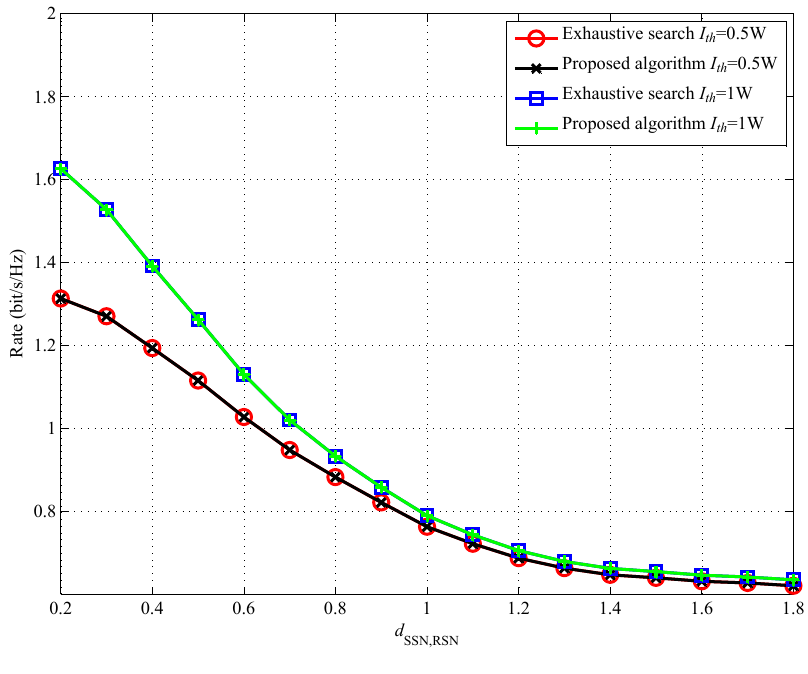
Figure 5. Achievable rate versus d SSN,RSN